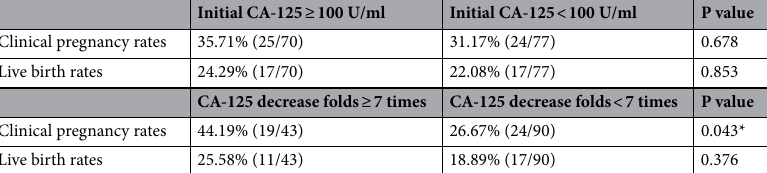
Table 4. The clinical outcomes of FET cycles by the initial serum CA-125 and fold decreases in CA-125 after treatment in group A and group EA. * p <